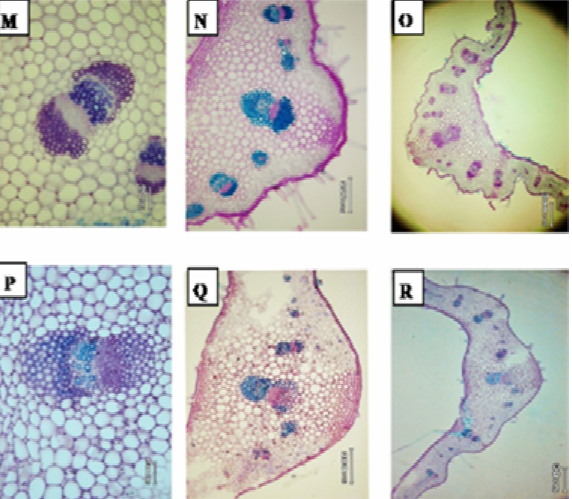
Fig. 4. Cross section of leaf in Onopordum species : (M-O): O. heteracanthum ,(P-R): O. carmanicum . (Scale bar=60 µm µm in M, P, X= 100; Scale bar=200 µm in N, Q, X= 40; Scale bar=300 µm in O, R,